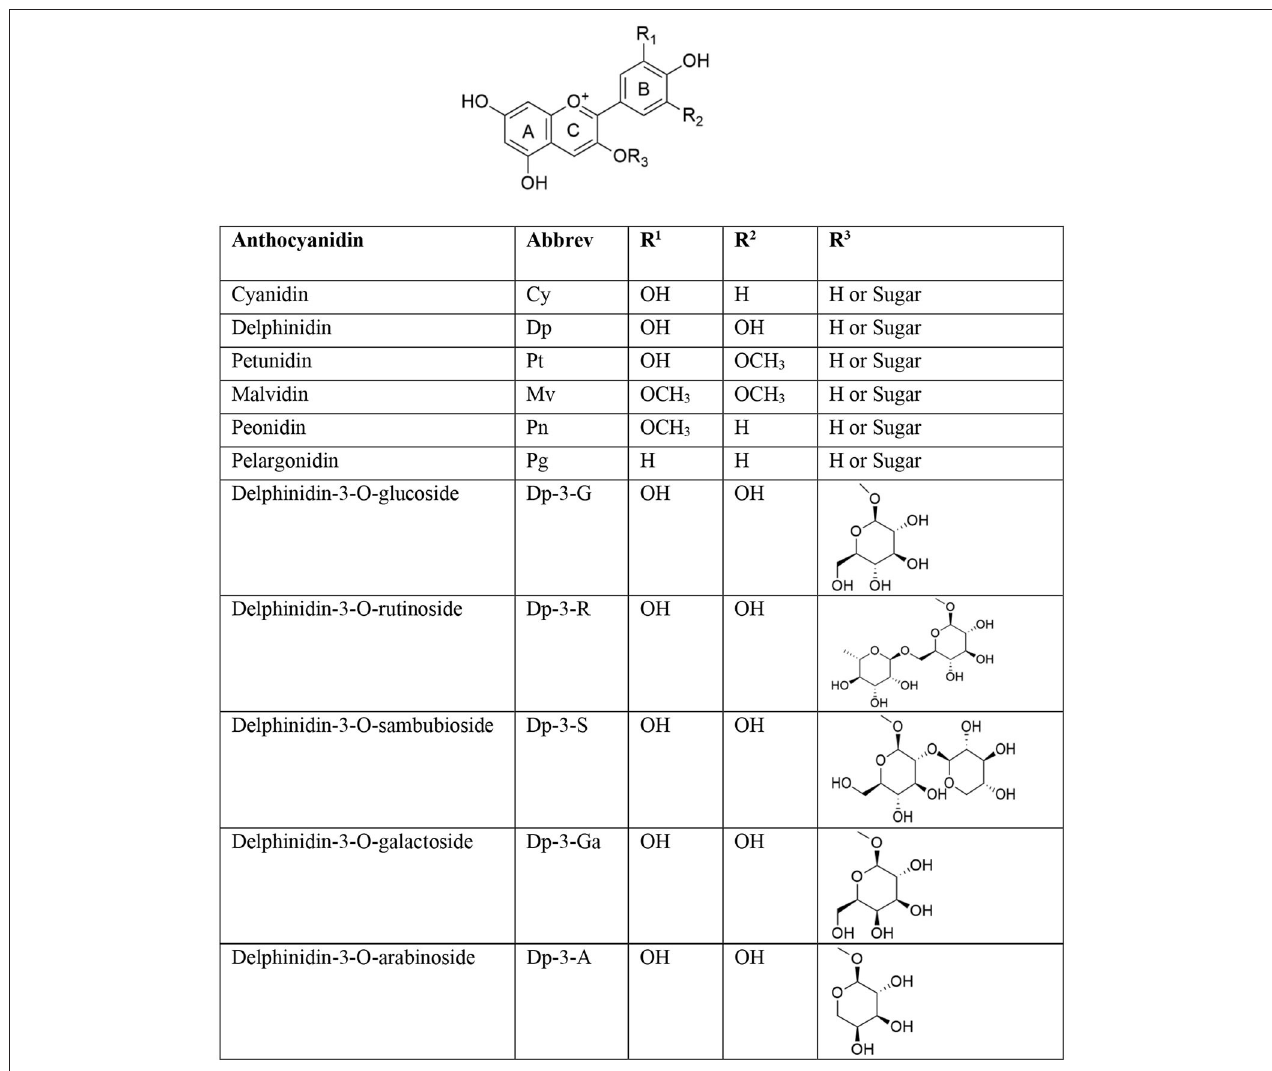
FIGURE 1 | Major anthocyanins and glycosidic forms of delphinidin present in